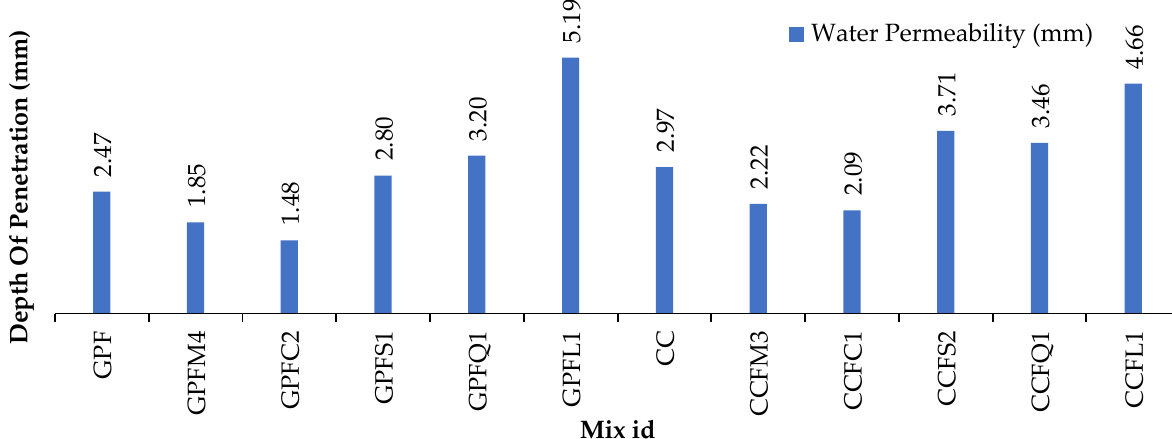
Figure 11. Co-efficient of permeability for GPC and cement concrete.